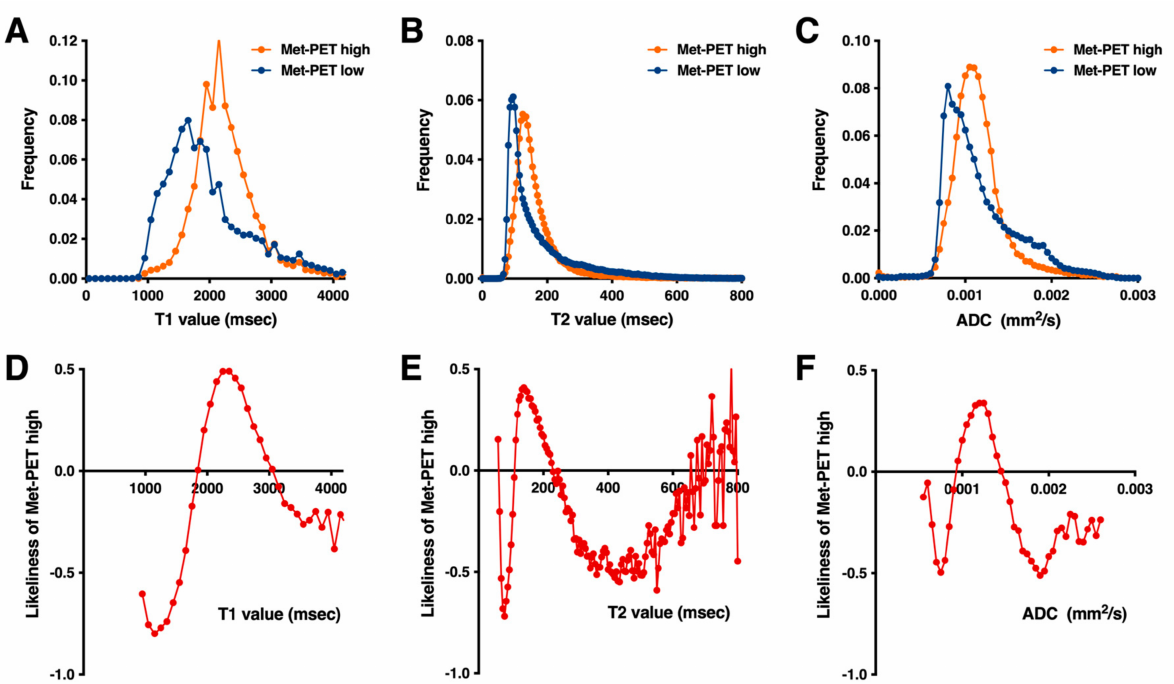
Figure 2. Correlation study between T1-, T2-relaxation times, ADC, and 11 C-methionine (MET) uptake. Frequency histograms of high MET uptake (T/N ratio >1.5; MET-PET high) and low (T/N ratio ≤ 1.5; MET-PET low) are presented as a function of T1- ( A ), T2-relaxation time ( B ), and ADC ( C ). Note that MET-PET high uptake skewed to the right, and widths were narrower than MET-PET low uptake in both T1- and T2-relaxation time. The likeliness of high MET uptake, as defined in the text, for T1- ( D ), T2-relaxation time ( E ), and ADC ( F ) are presented. These three graphs show the likeliness of MET-PET high or low uptake as a function of T1-, T2-relaxation times and ADC. Source data are provided in Tables